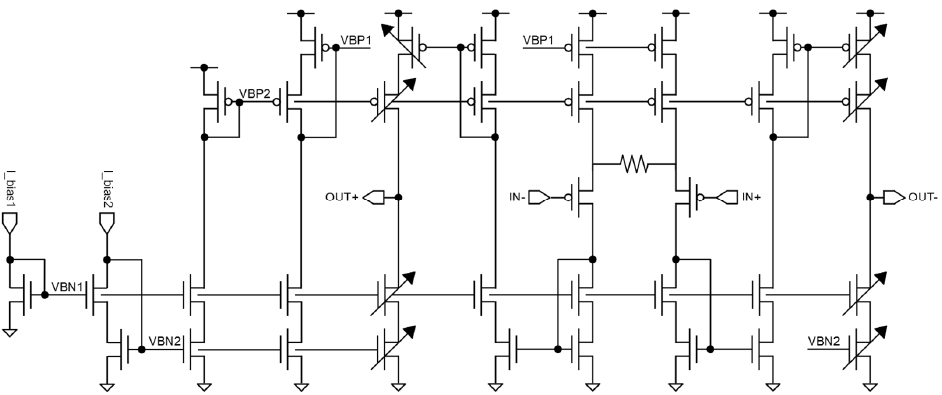
Figure 7. A simplified schematic diagram of the transconductance amplifier.